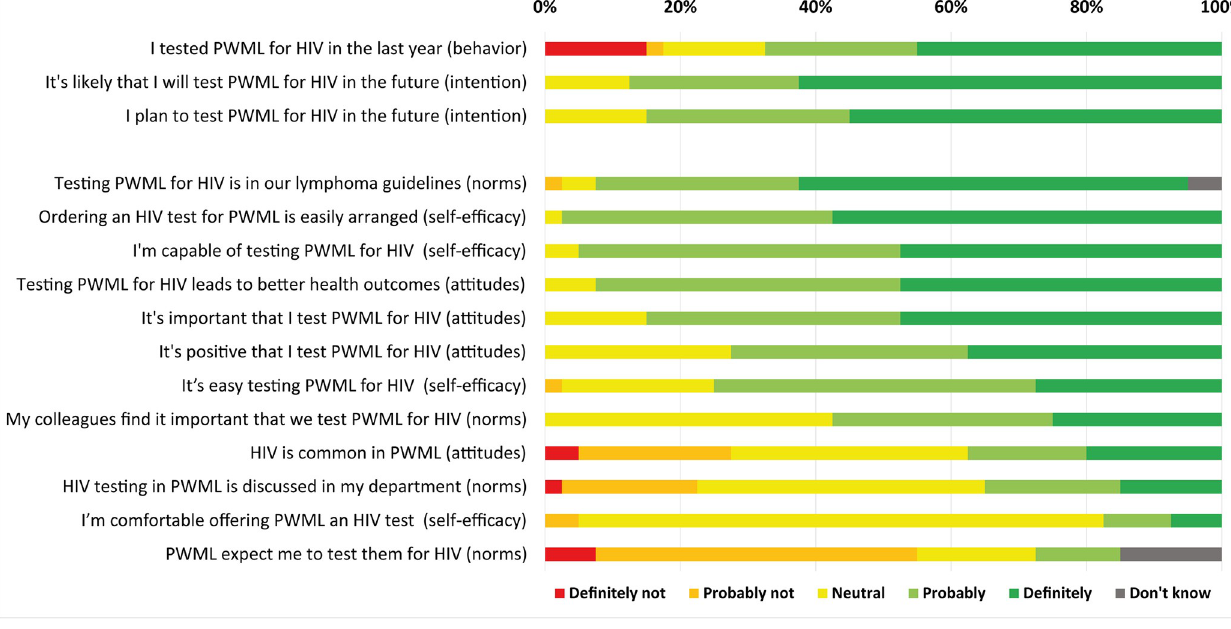
Fig 2. Questionnaire responses on barriers and facilitators for HIV testing among patients with malignant lymphoma by 40 hematology physicians from 5 hospitals in the region of Amsterdam, 2020, ranked by statement score. PWML: patients with malignant lymphoma.